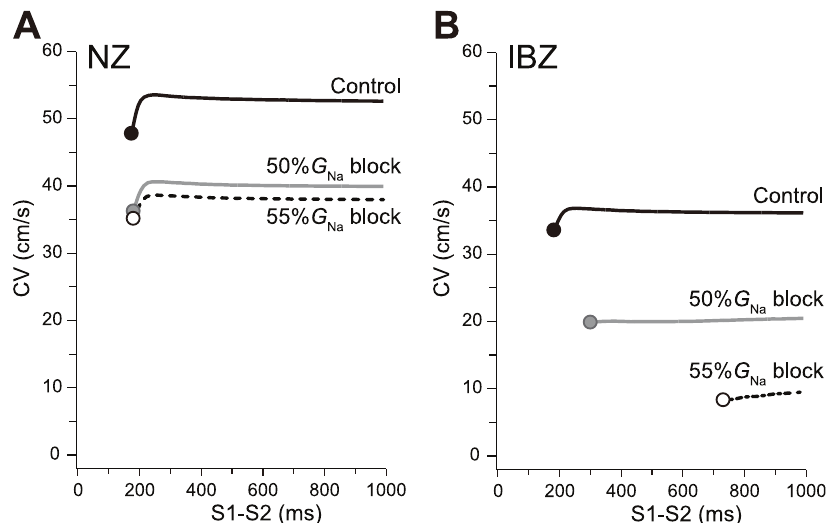
Figure 4. Conduction velocity restitution properties. Conduction velocity (CV) restitution curves in the NZ (A) and IBZ (B) myofiber models as a function of S1–S2 interval. Ten S1 stimuli of basic cycle length (400 ms) were applied transmembranously followed by an S2 stimulus with various coupling intervals.